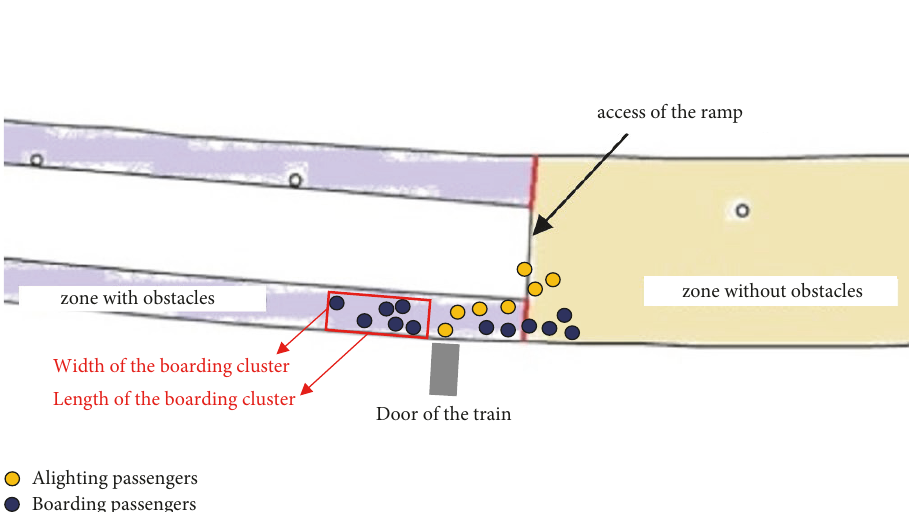
Figure 1: Boarding clusters along obstacles (narrow zones) on railway platforms. In [15] the clusters are represented by a rectangular shape (width and length) which is aligned in the longitudinal direction of the